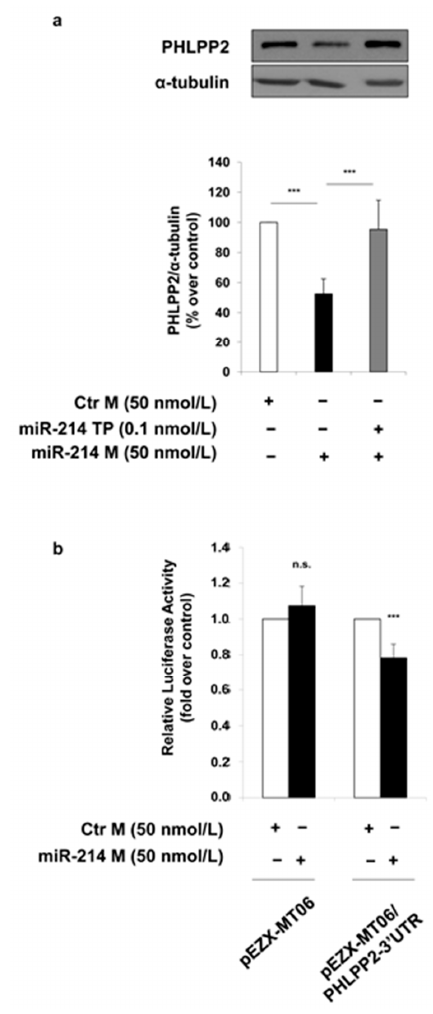
Figure 4. Effect of miR-214 on PHLPP2 regulation. ( a ) MAECs were transfected with a non-targeting control oligonucleotide (Ctr M; white bars) or miR-214 mimic (miR-214 M 50 nmol/L; black bars). Where indicated, MAECs were co-transfected with miScript miR-214 Target Protector (miR-214 TP 0.1 nmol/L). Protein lysates obtained from 48 h transfected MAECs were analyzed by Western blot with anti-PHLPP2 and anti- α -tubulin antibodies. Exposure timing of blots was of 2 min. Protein levels were quantified by the densitometric analysis of at least three independent experiments. Bars in the graphs represent the mean ± SD of the percent (%) over control (Ctr M). ( b ) MAECs were transfected for 24 h with non-targeting control oligonucleotide (Ctr M 50 nmol/L; white bars) or miR-214 mimic (miR-214 M 50 nmol/L; black bars) in the presence of the pEZX-MT06 control reporter vector or the pEZX-MT06/PHLPP2-3 ′ UTR reporter vector. Firefly and Renilla luciferase activities were determined in cell lysates under each experimental condition. Results are normalized to Renilla activity. Bars in the graphs represent the mean ± SD of the fold over control (Ctr M). Statistical analysis was evaluated using Student’s t -test; *** p ≤ 0.001.